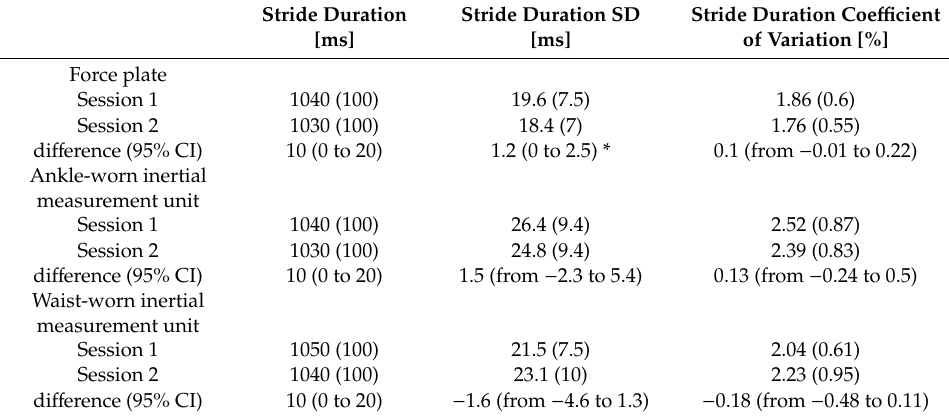
Table 1. Stride characteristics measured from n = 27 (waist-worn inertial measurement unit n = 26) participants in the first and the second measurement session a week apart with the two methods. Reliability values are given in the text.